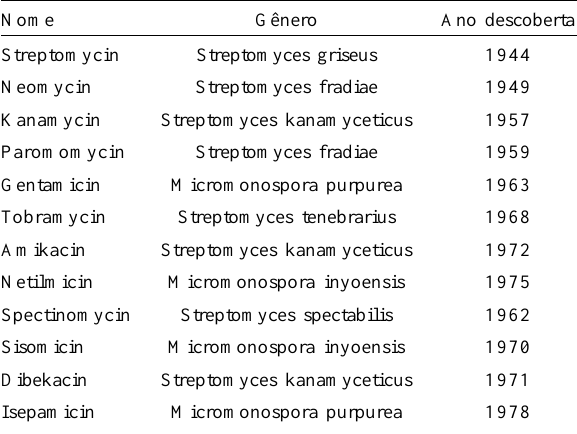
Tabela 1. Relação dos aminoglicosídeos, sua origem e ano de